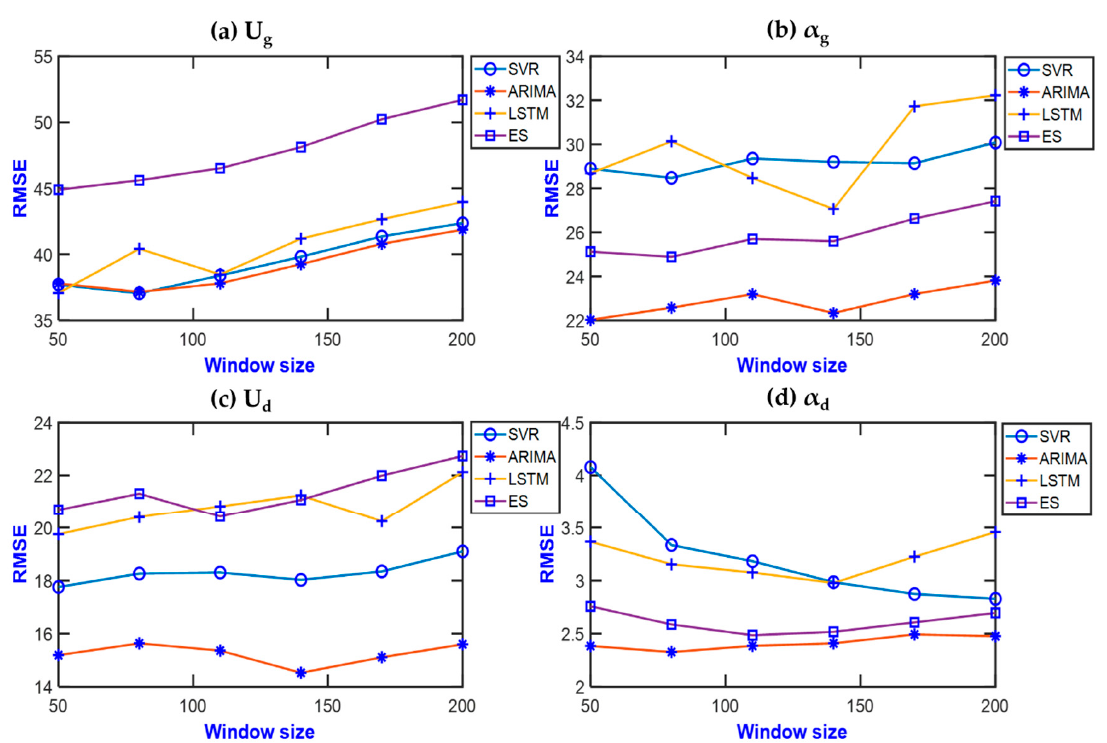
Figure 14. RMSE with variation of window size using expanding window method of ( a ) U g ( b ) α g ( c ) U d ( d ) α d .